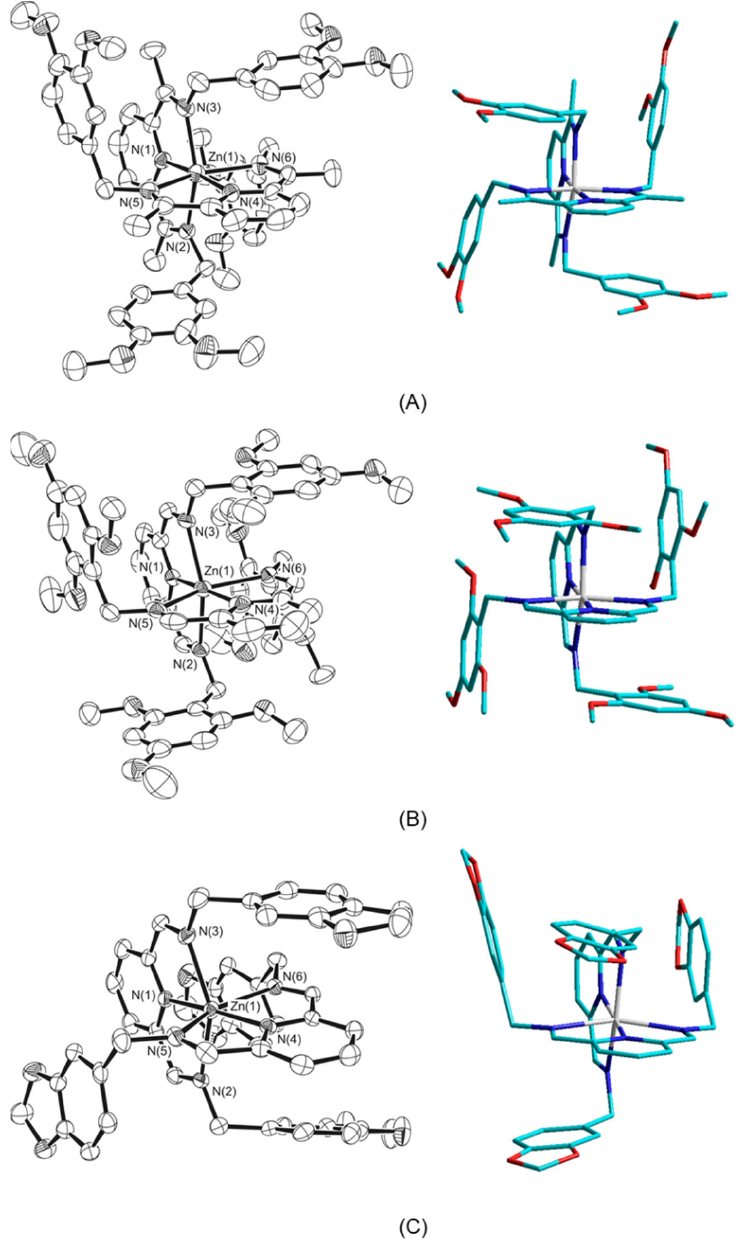
Figure 6. Plots showing thermal ellipsoids (left) and simplified sketches (right) of the three Zn II complexes: ( A ) [Zn( 5b ) 2 ](CF 3 SO 3 ) 2 · MeOH; ( B ) [Zn( 7a ) 2 ](CF 3 SO 3 ) 2 ; ( C ) [Zn( 8a ) 2 ](CF 3 SO 3 ) 2 ; ellipsoids are drawn at the 30% probability level; hydrogen atoms, triflate counterions and additional solvent molecule are omitted for clarity; atom symbols are shown only for nitrogen and metal center.